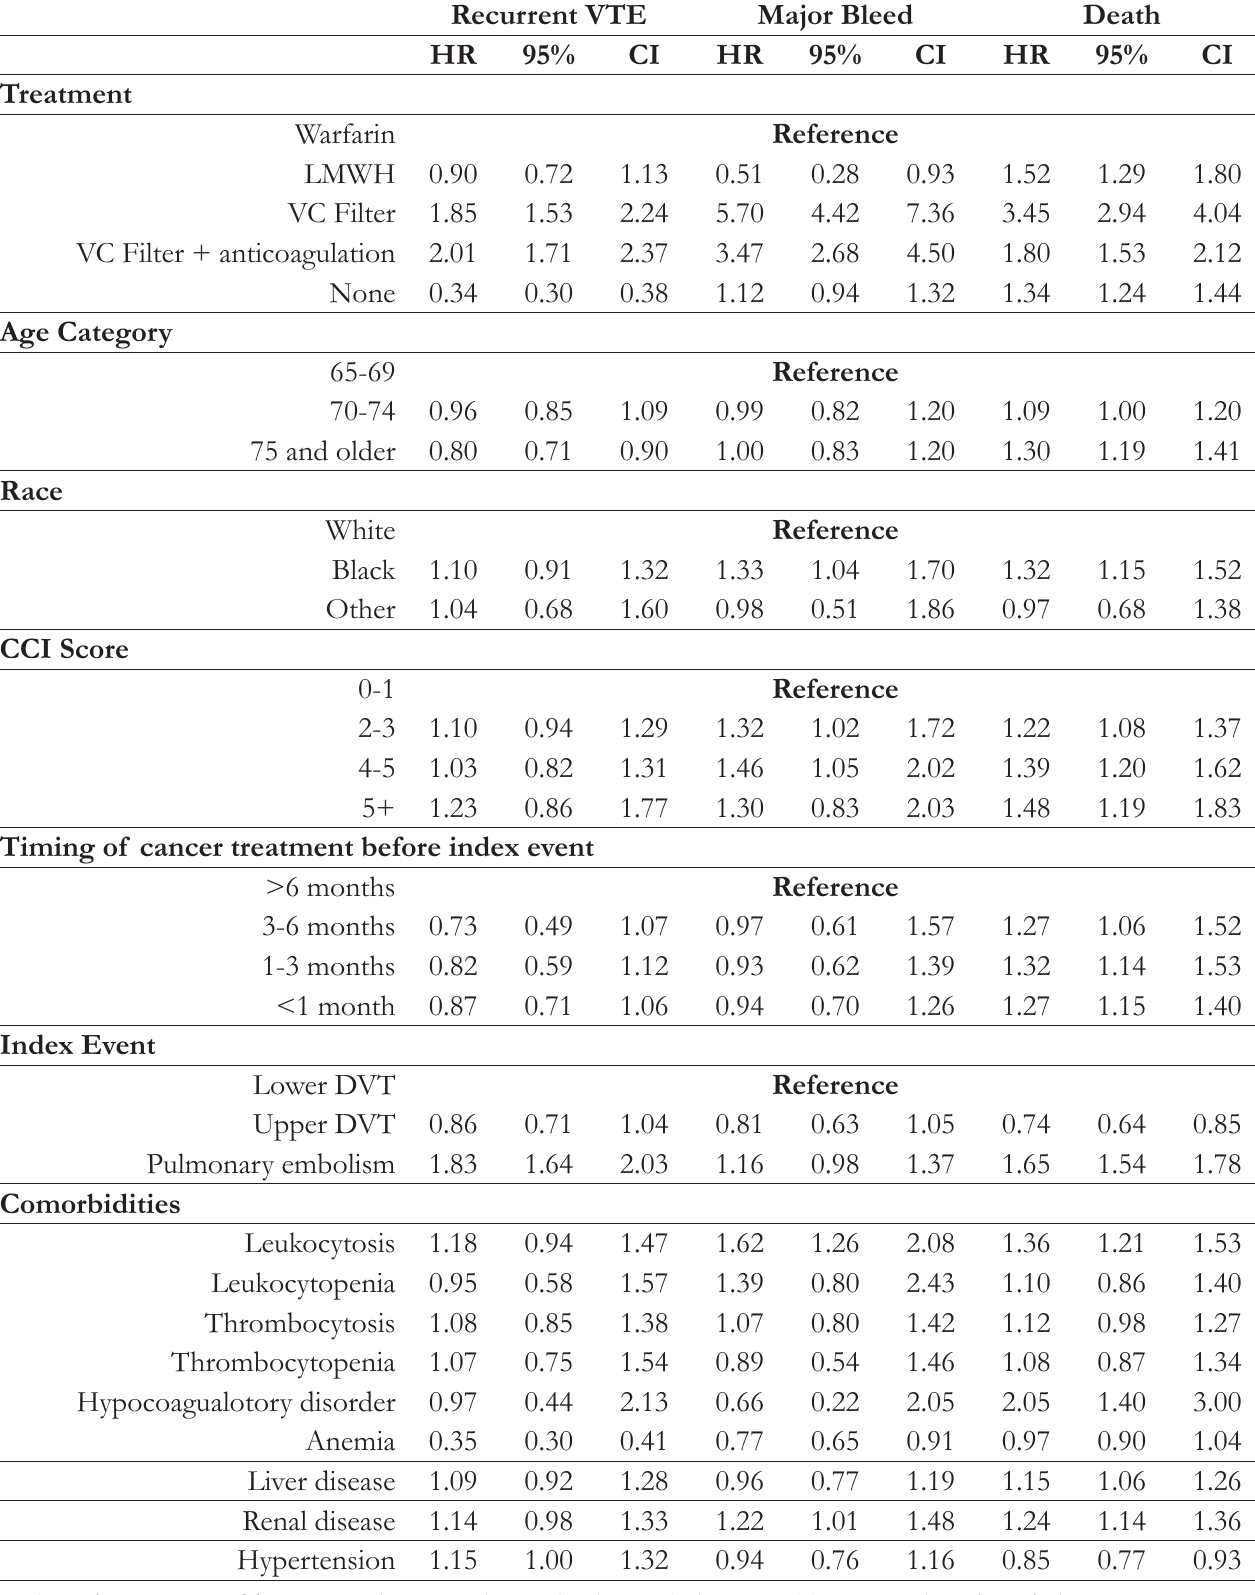
Table 3. Event Specific Hazard Ratios and 95% Confidence Intervals from IPTW Competing Risks Analysis Recurrent VTE Treatment